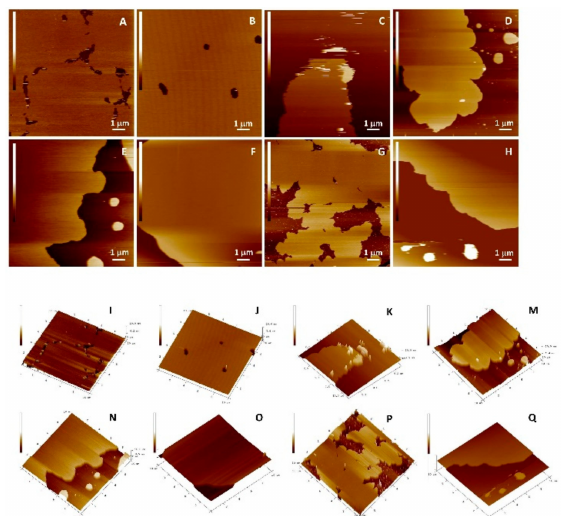
Figure 10. Top view of height AFM images on the model (DOPC) SLB without ( x = 0) and with inserted QUE at di ff erent molar fractions before the induced lipid peroxidation. 2D view: ( A ) DOPC ( x = 0); ( B ) ( x = 0.01); ( C ) ( x = 0.05); and ( D ) ( x = 0.10). 3D view: ( I ) DOPC ( x = 0); ( J ) ( x = 0.01); ( K ) ( x = 0.05); and ( M ) ( x = 0.10). After the induced lipid peroxidation, 2D view: ( E ) DOPC ( x = 0); ( F ) ( x = 0.01); ( G ) ( x = 0.05); and ( H ) ( x = 0.10). 3D view: ( N ) DOPC ( x = 0); ( O ) ( x = 0.01); ( P ) ( x = 0.05); and ( Q ) ( x = 0.10). Scales of all images are 6 nm.